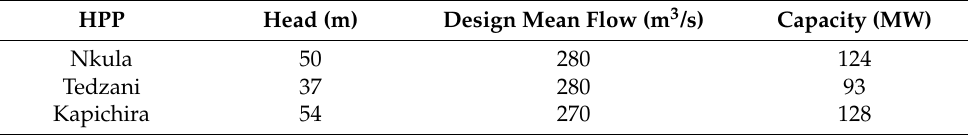
Table 1. The current installed cascade hydropower plants’ capacities along Shire River.